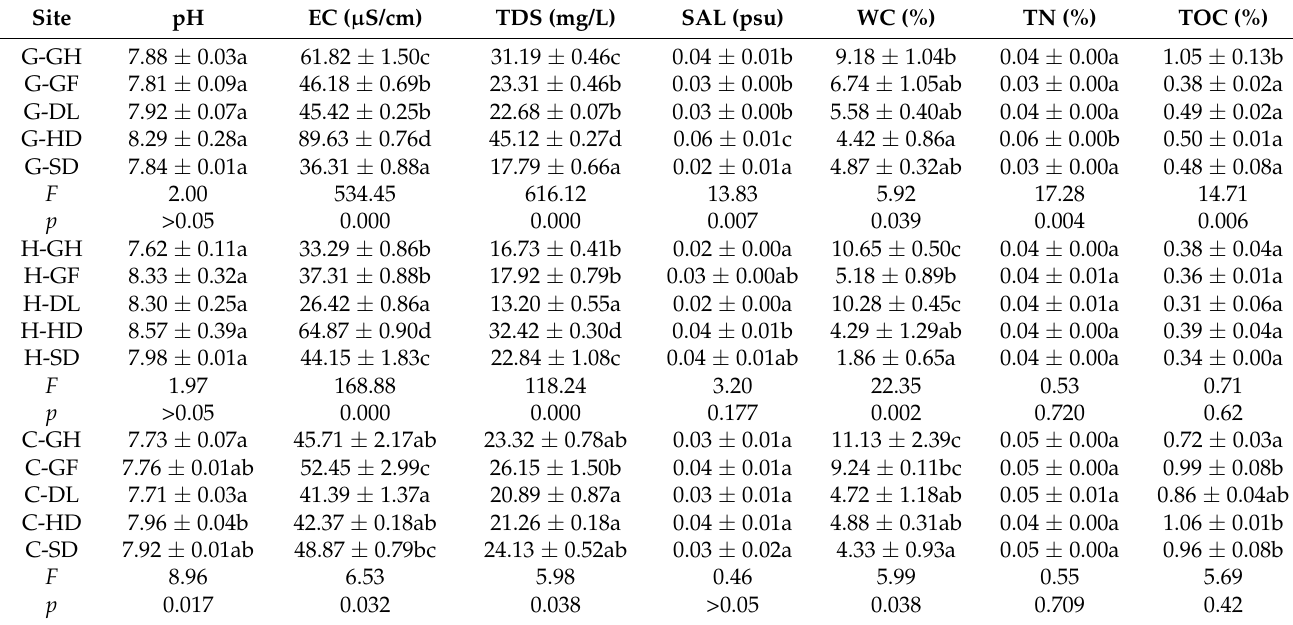
Table 1. Soil properties (mean ± SE) of different habitats across 3 sites soil sampled from cold-desert, Qinghai–Tibet Plateau, China. Different letters indicate significant differences across the habitats for each site based One-way ANOVA and Duncan comparisons. F and p -values obtained in ANOVA’s are shown at the bottom of each site. CNH—CuoNaHu, HLH—HongLiangHe, GEM—GeErMu.